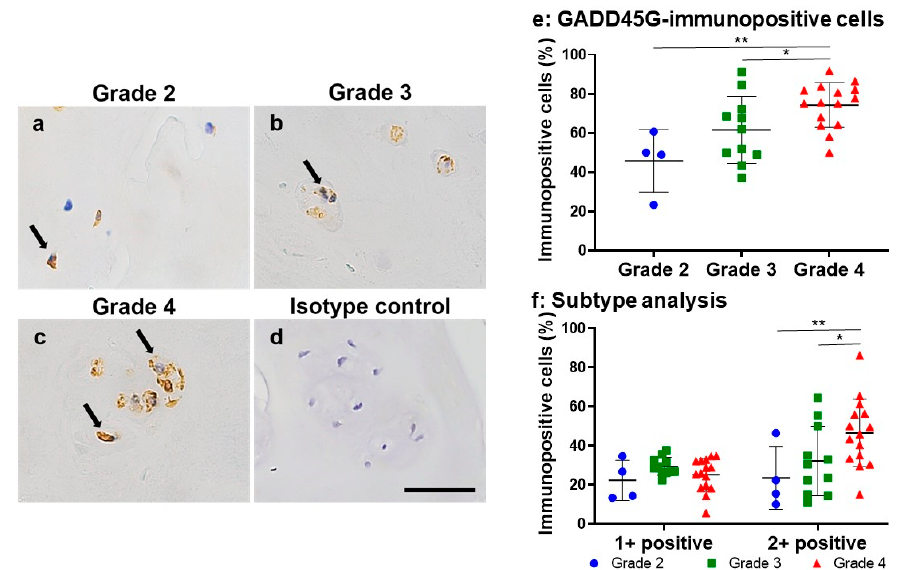
Figure 7. Immunohistochemical staining for GADD45G ( a – c ) in human nucleus pulposus (NP) tissues. Pfirrmann grade 2 ( a ), grade 3 ( b ), grade 4 ( c ), and isotype control ( d ). Scale bar: 50 μ m (×400 magnification). Percentage of immunopositive cells for GADD45G ( e ) and the subtype analysis by the intensity of immunostaining ( f ) in human nucleus pulposus (NP) tissues by Pfirrmann classification. * p < 0.05, ** p < 0.01.